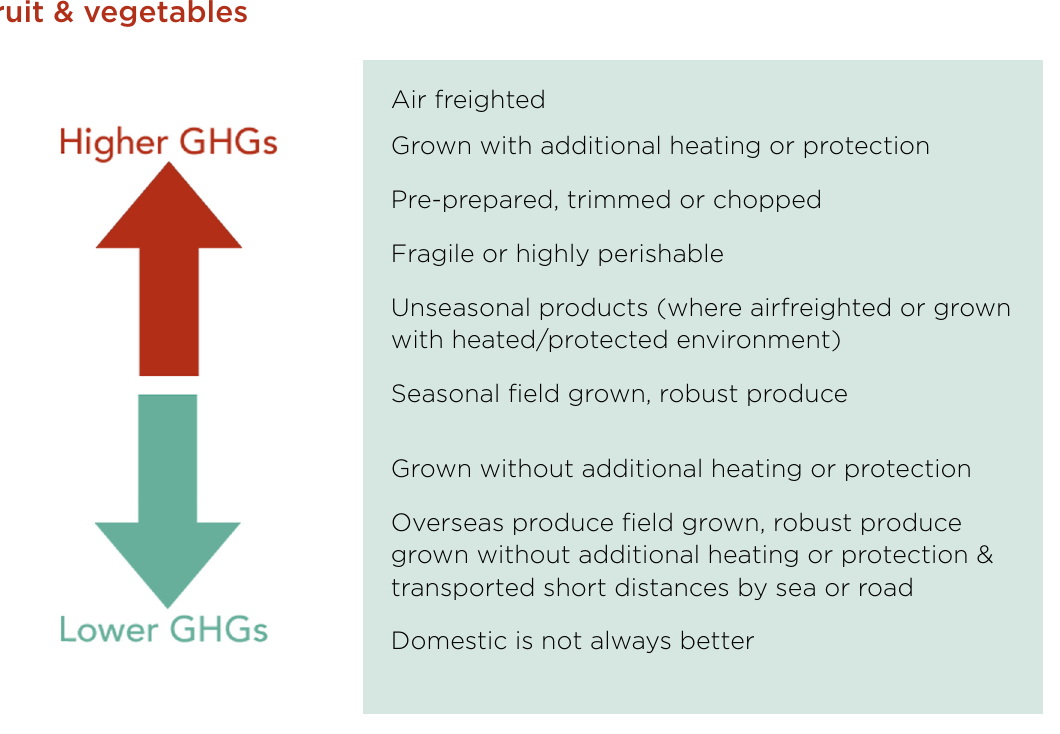
Figure 11: Hierarchy of greenhouse gase emissions from fruit and vegetables. Source: FCRN.